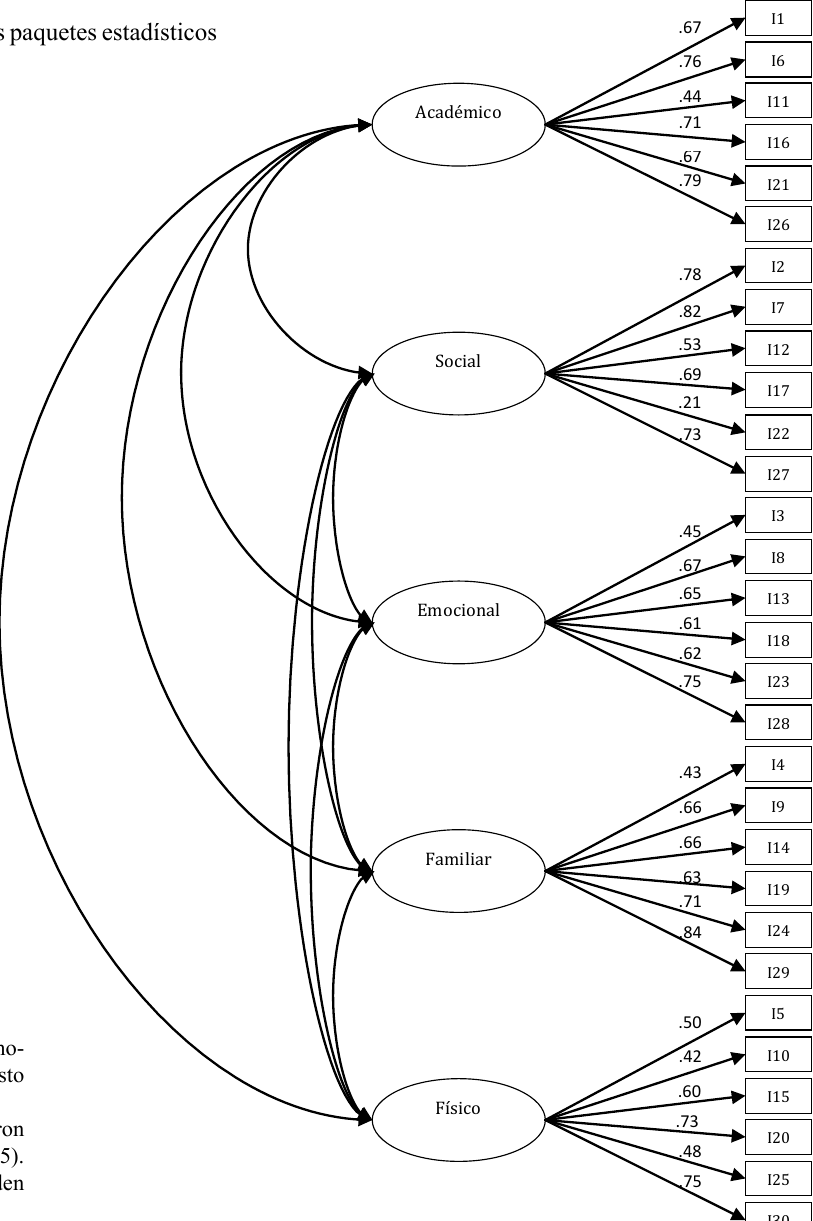
Figura 1. Saturaciones factoriales del mo- delo de ecuaciones estructurales propuesto para la Escala Autoconcepto Forma 5. Notas . Todas las cargas factoriales fueron estadísticamente signi fi cativas ( p < .05). Los valores de las correlaciones pueden observarse en la Tabla